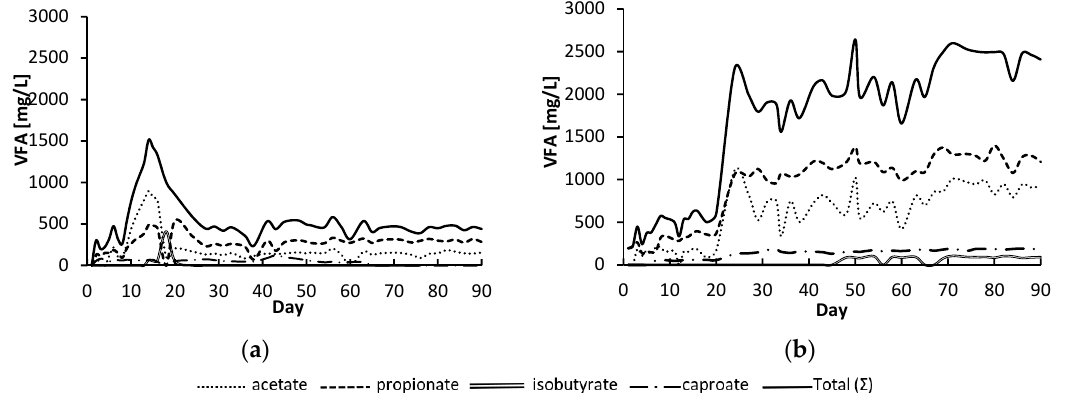
Figure 5. Qualitative and quantitative changes of volatile fatty acids (VFA) during the anaerobic digestion of ORF after autoclaving; ( a ) mesophilic—temperature 37 °C, ( b ) thermophilic—temperature 55 °C.